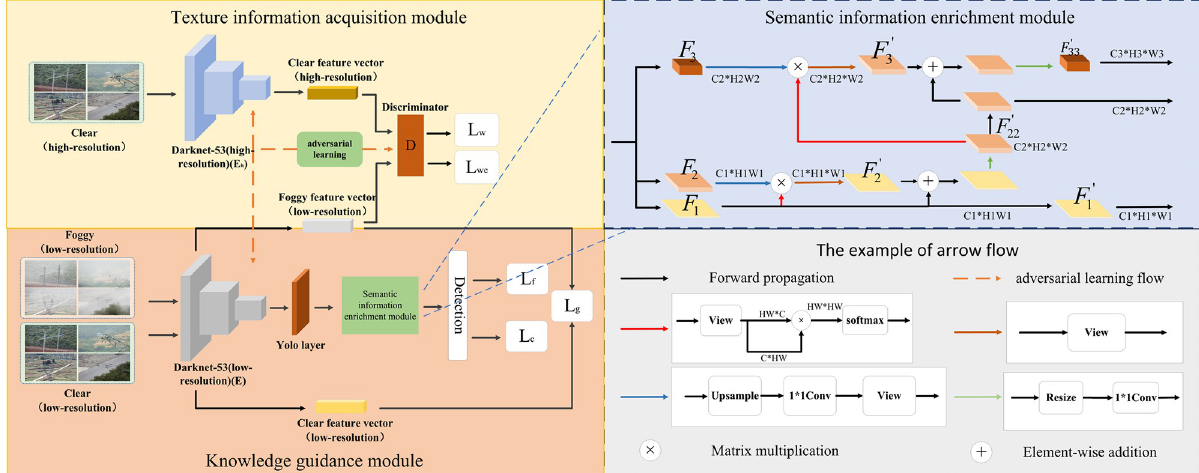
Fig 2. The texture and semantic integrated small objects detection algorithm in foggy